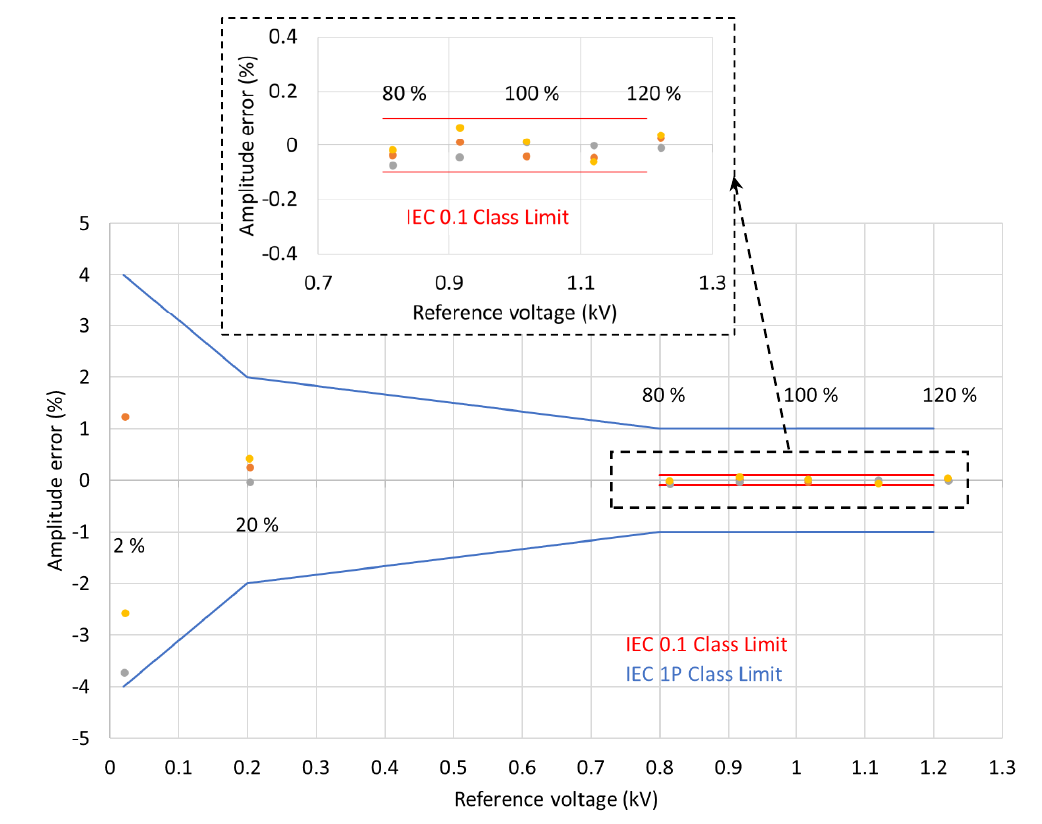
Figure 8. MVT voltage amplitude errors.